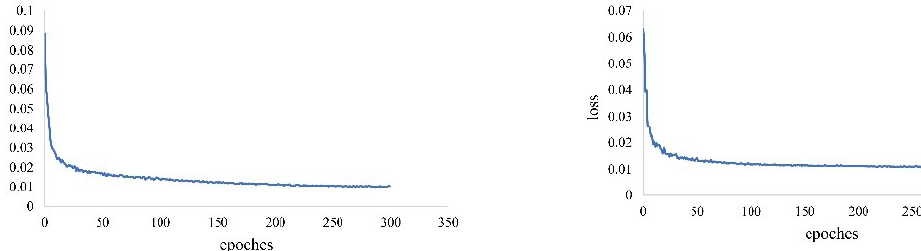
Figure 9. Curve of loss value of bounding box .